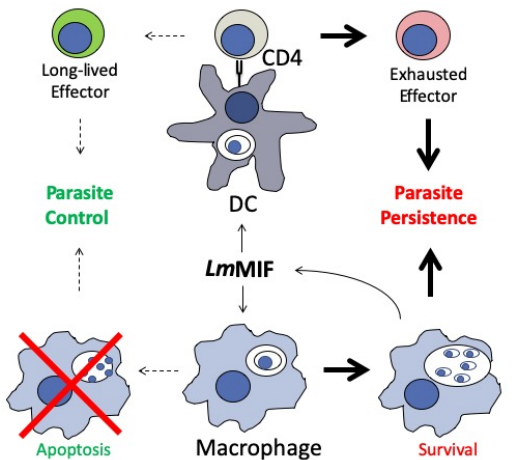
Figure 3. Leishmania MIF signals through the CD74 receptor on host macrophages and dendritic cells. It blocks macrophage apoptosis and simultaneous promotes dendritic cell-mediated T cell activation, resulting in increased T effector cell exhaustion and ultimately prolonged parasite persistence. Adapted from Holowka et al. 2016 [104].